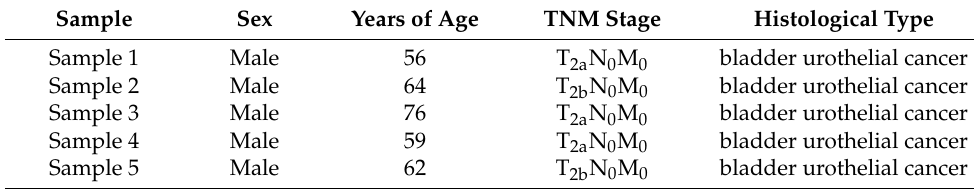
Table 1. The clinical information of the patients for